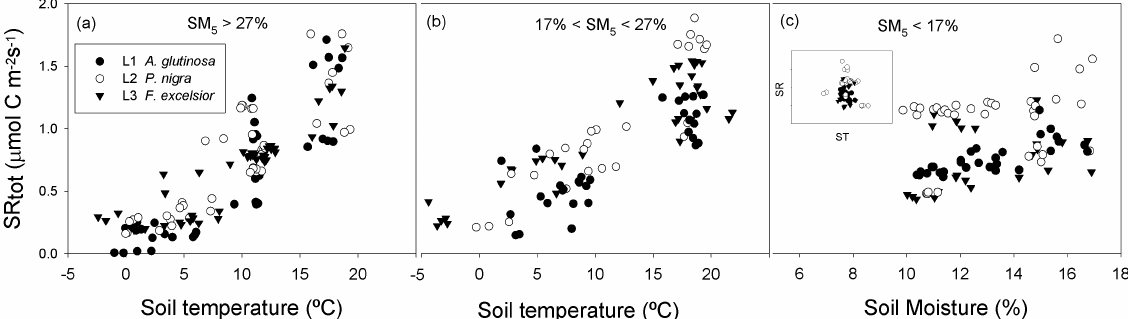
Figure 5. Differentiation of soil temperature (ST) and soil moisture (SM) as primary controlling factors for SR tot . At SM 5 ≥ 27%, there are positive correlations of SR tot with soil temperature under all tree species (a) . At 17% ≤ SM 5 < 27%, there are positive but slightly weaker correlations of SR tot with soil temperature under all tree species (b) . At SM 5 < 17%, there is no relationship between SR and ST as the inset figure shows (c) ; it switches from ST to SM 5 as the controlling factor with positive correlations between SR tot and SM 5 for all tree species. Campaigns with SM 5 < 17% were all from spring and summer 2012. SM 5 (5cm integral soil